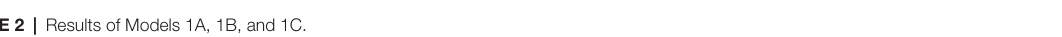
FIGURE 3 | Proportion of looks over time to the target object across conditions in German (L1). The shaded area corresponds to the analysis window.